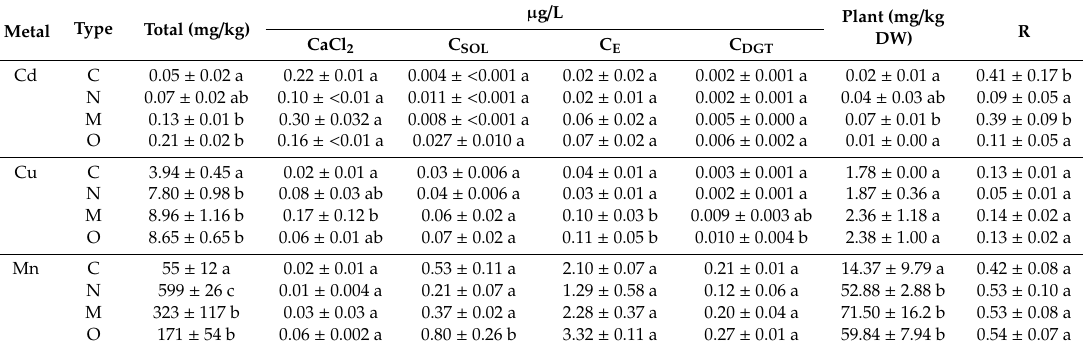
Table 2. Metal concentrations (Cd, Cu, Mn, Ni and Zn) in soil, wheat, DGT, C E , C SOL , CaCl 2 extractable metals for soil and soil after the growth of